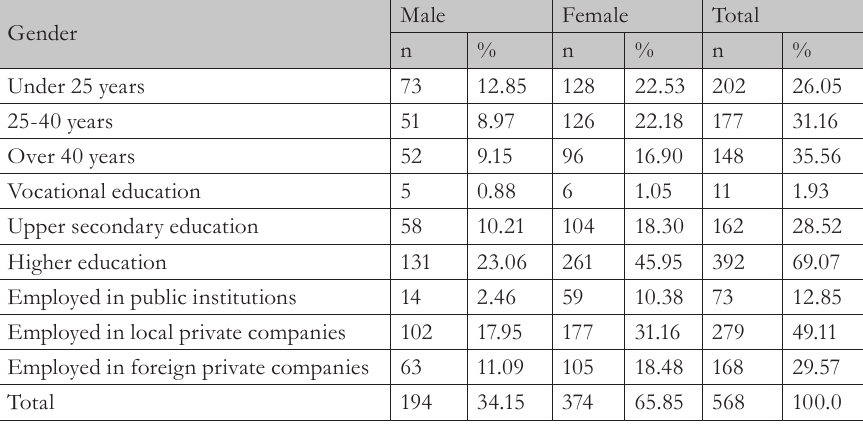
Tab. 1 – Sample structure. Source: own